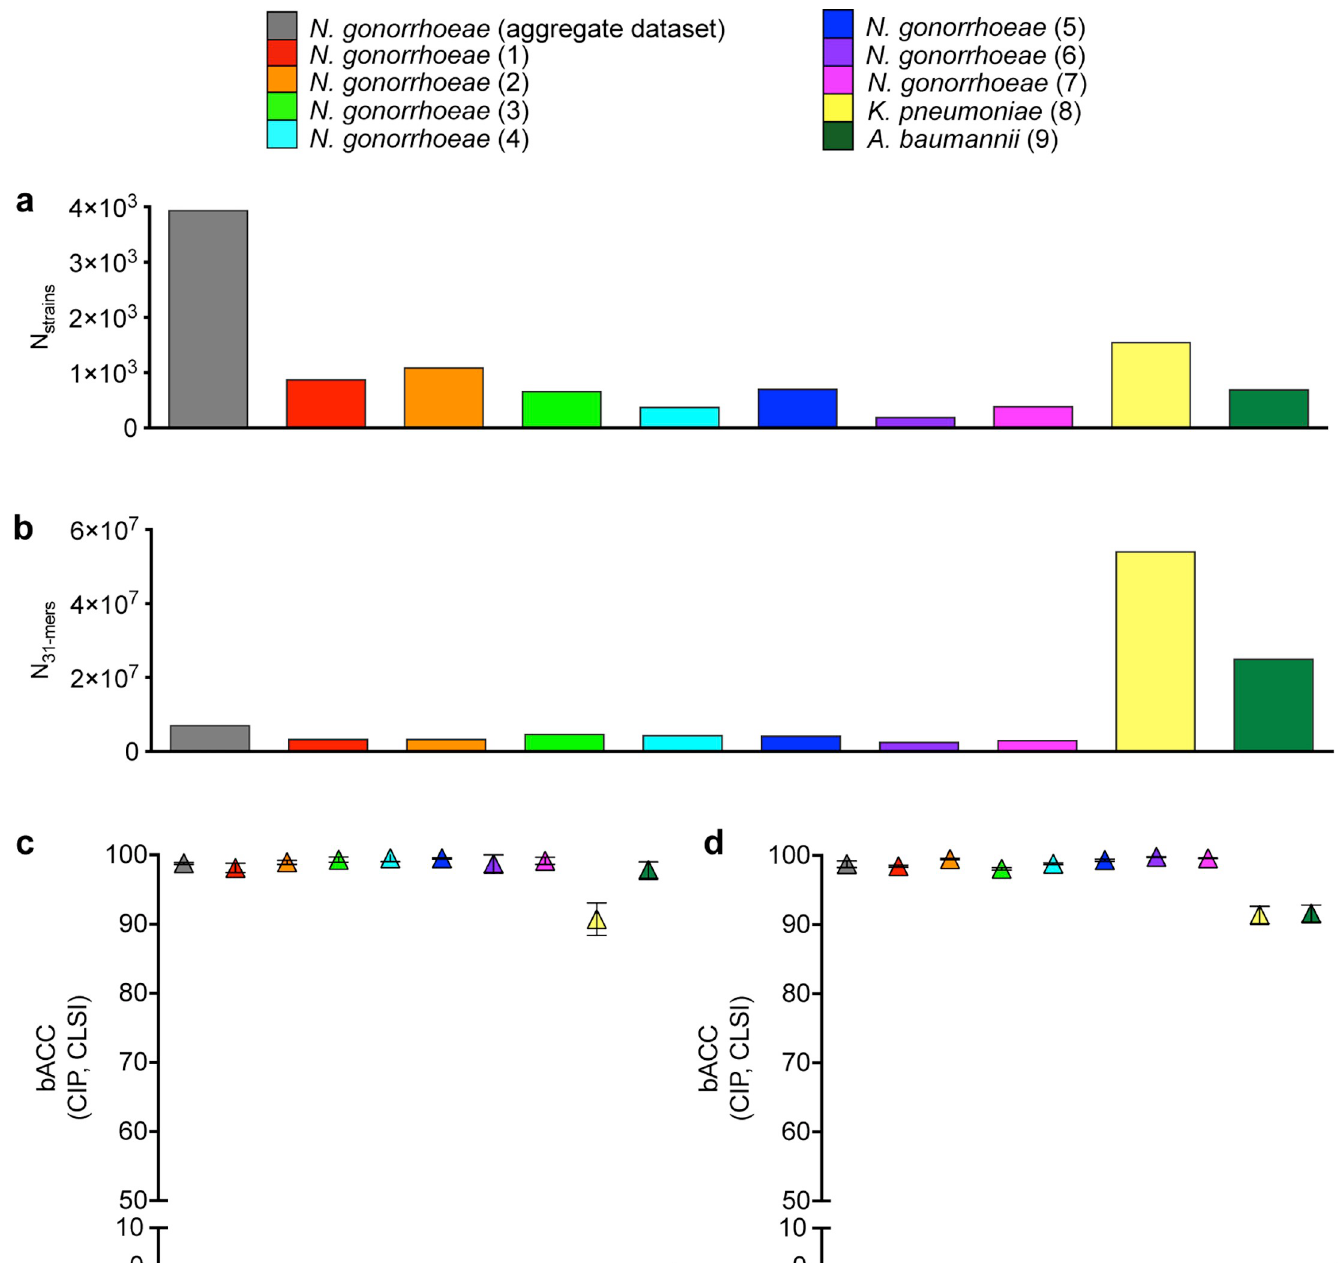
Fig 4. K . pneumoniae and A . baumannii datasets are associated with higher genetic diversity and lower performance of resistance prediction models. Number of (a) strains and (b) unique 31-mers present in the genomes of at least two strains in each dataset. Mean balanced accuracy (bACC) with 95% confidence intervals achieved by (c) set covering machine and (d) random forest classification models for ciprofloxacin (CIP) NS by the CLSI breakpoints across gonococcal, K . pneumoniae , and A . baumannii